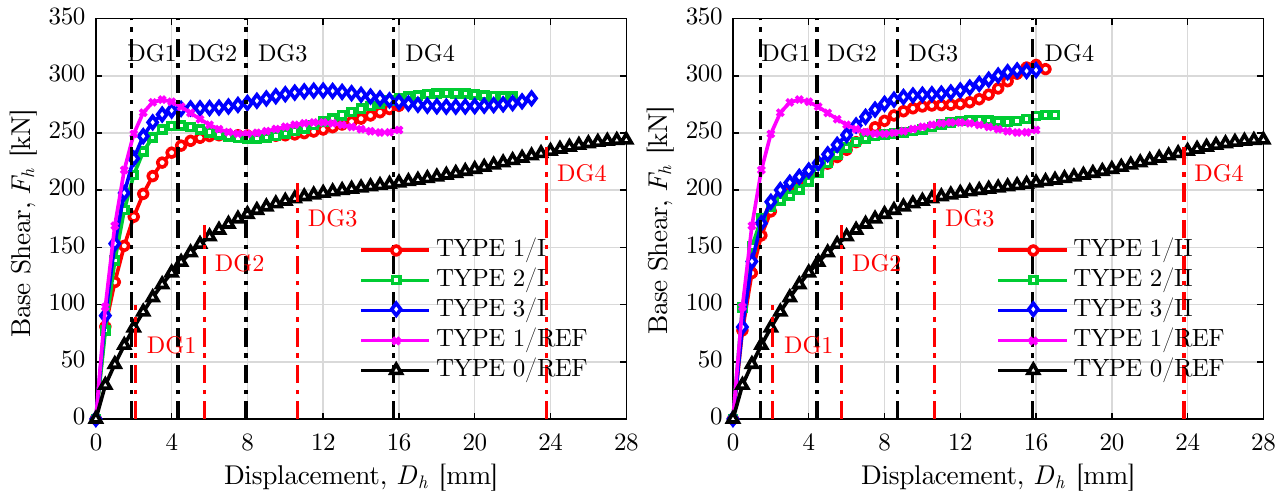
Figure 9. Averaged response envelope curves for all tested specimens